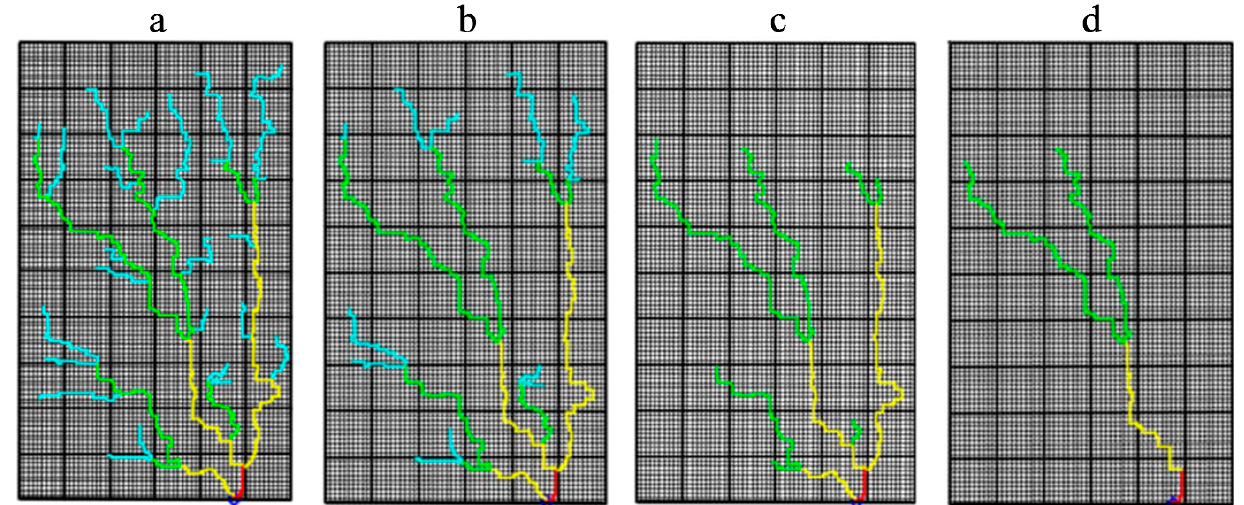
Figure 9. Curvilinear branchwork patterns with different conduit densities in scenario B. ( a – d ) represent the base curvilinear branchwork model, with 25%, 50%, and 75% reduction in the length of conduits, respectively. Rectilinear branchwork and network maze patterns with different conduit densities in scenario B can be found in the Supplementary Materials (Figures S1 and S2, respectively).